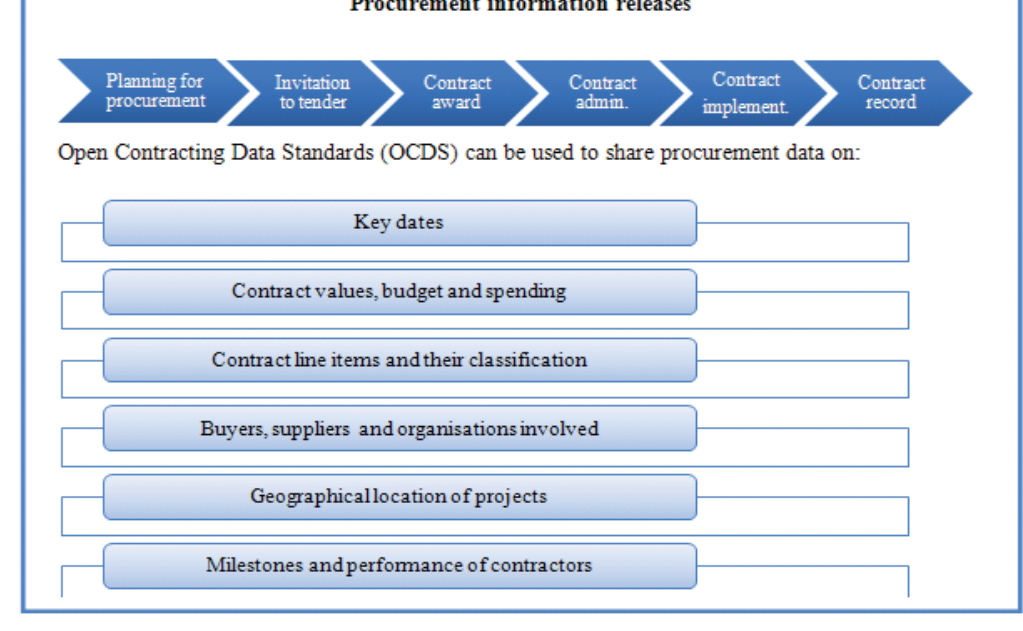
Fig. 1. Application of Open Contracting